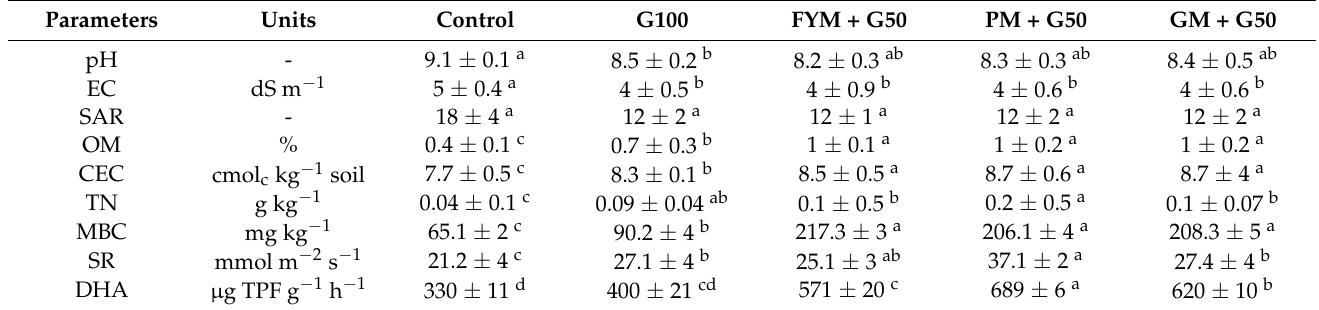
Table 3. Post-harvest soil analysis. Note: EC = electrical conductivity, SAR = sodium adsorption ratio, OM = organic matter, CEC = cation exchange capacity, TN = total nitrogen, MBC = microbial biomass carbon, SR = soil respiration, DHA = dehydrogenase activity. Rounded-off values after ± represents standard error ( n = 3). Different letters indicate statistical difference (LSD, p <